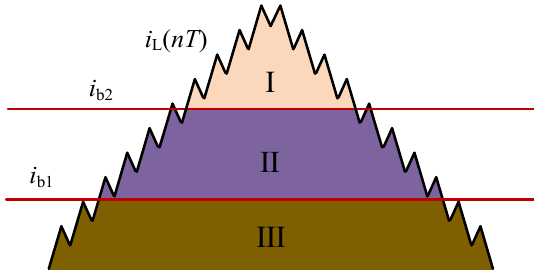
Figure 5. Regions of inductor current i L .